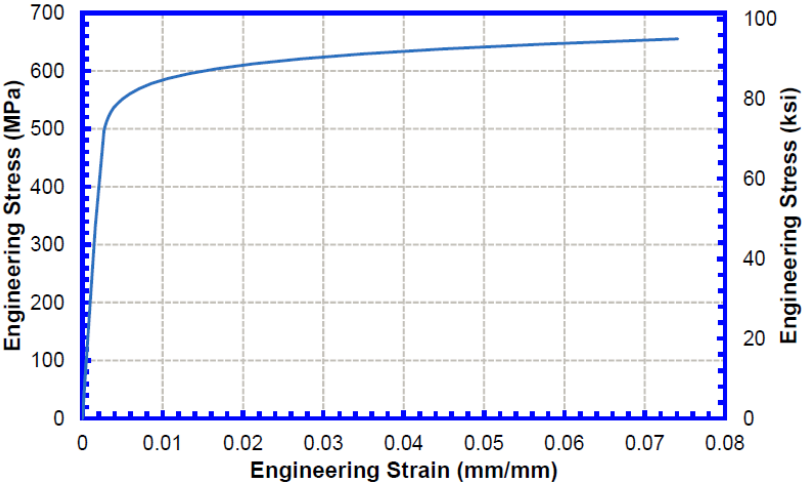
Figure 5. Stress–strain curves of weld Figure 5. Stress – strain curves of weld metal.